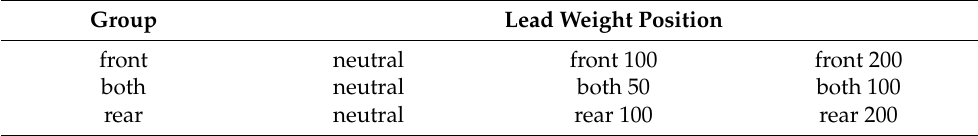
Table 2. Groupings for the lead weight